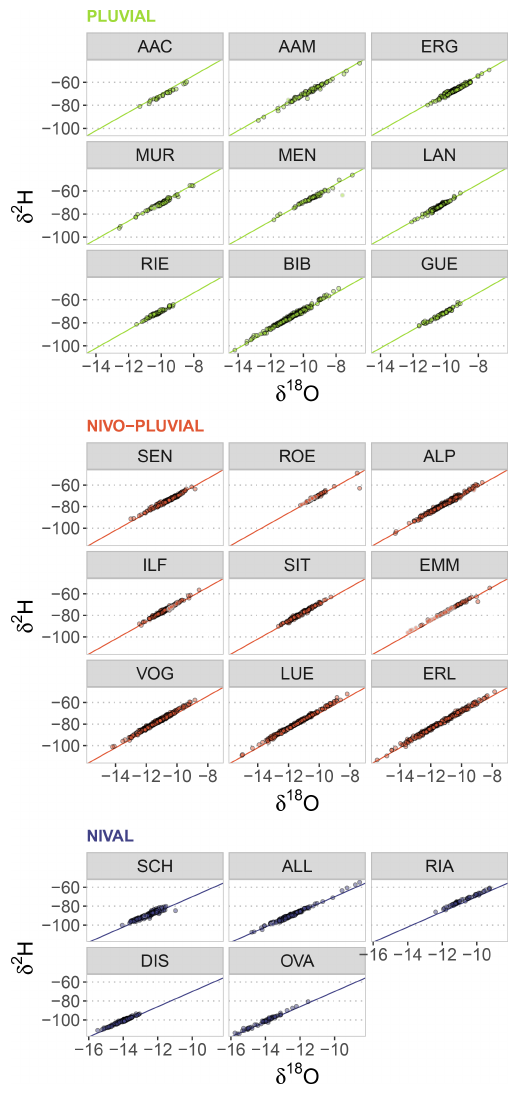
Figure 4. Comparison of the relation between δ 18 O and δ 2 H to the global meteoric water line (GMWL). The colours indicate the regime type to which the catchments were assigned. Note the dif- ferent x -axis scaling for the nival